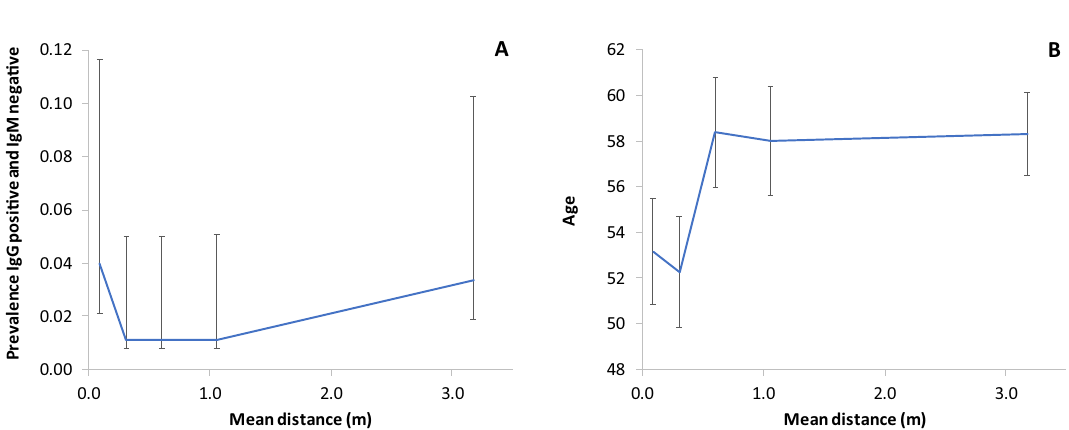
Figure 8. ( a ) Prevalence of IgG positive and IgM negative case as function of their distance (five equi— represented classes) to the nearest phase 1 infected subjects. ( b ) Mean age of subjects within the same distance classes (irrespective of